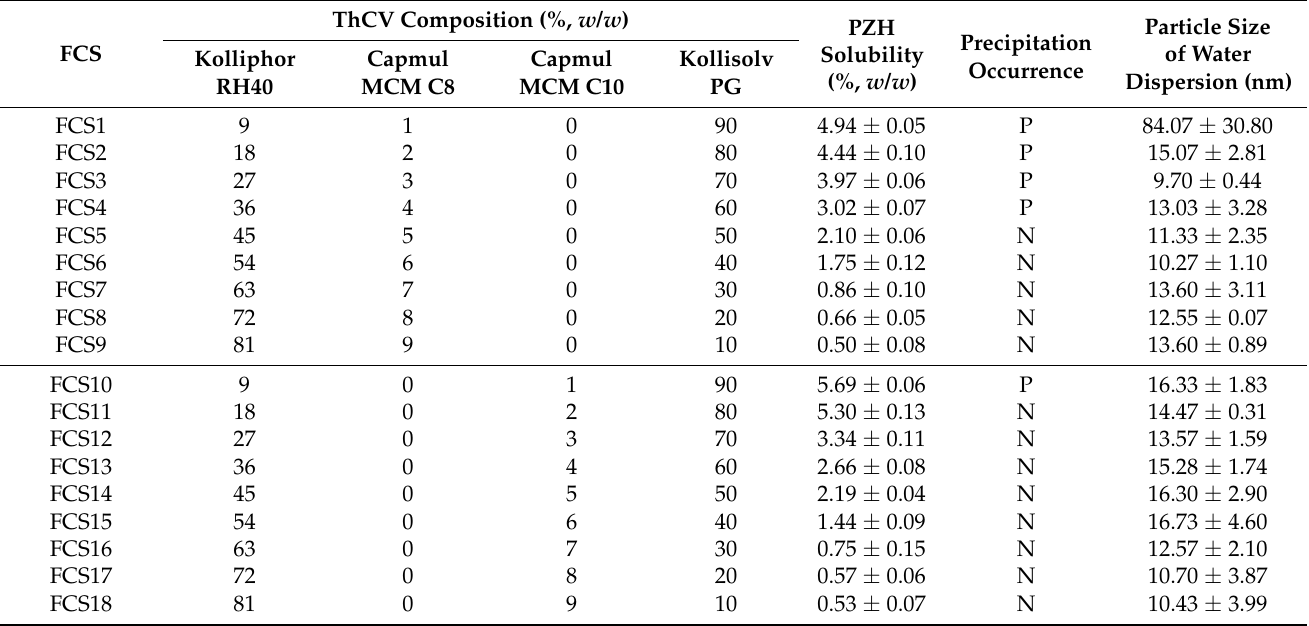
Table 2. The PZH solubility, precipitation occurrence, and particle size of water dispersion, for the